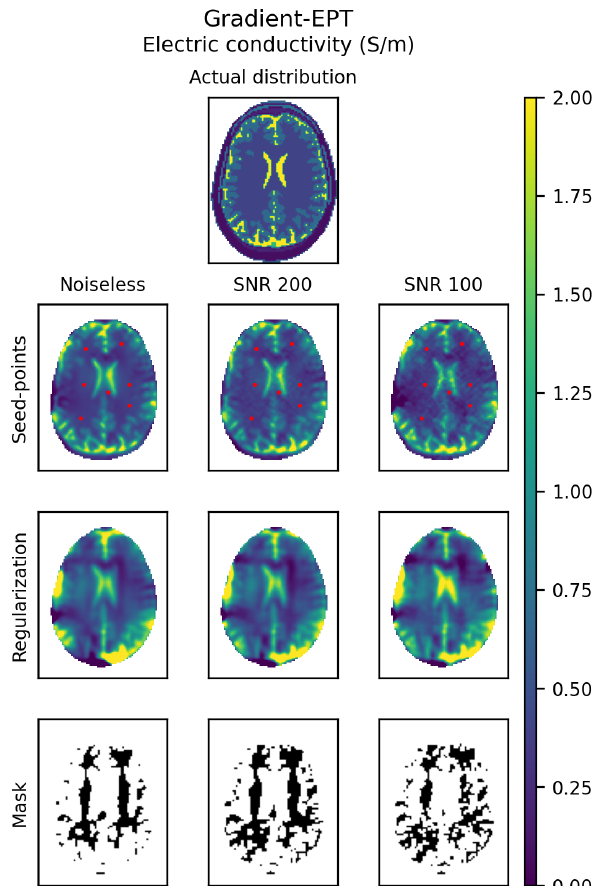
Figure 8. Electric conductivity distributions recovered by gradient-EPT and actual distribution at 300MHz. The distributions recovered with the seed point constraint use a cross window of size [2,2,2] for the Savitzky–Golay filter. The selected seed points are marked by red dots. The distributions recovered with regularization use a cuboid window of size [2,2,2] for the Savitzky–Golay filter and a regularization coefficient λ = 10,000. The masks adopted for regularization are obtained with a tolerance k = 0.02 in the noiseless case and k = 0.03 in the noisy cases. The resulting masks are reported. Results obtained with different amount of noise (noiseless, SNR = 200 and SNR = 100) are